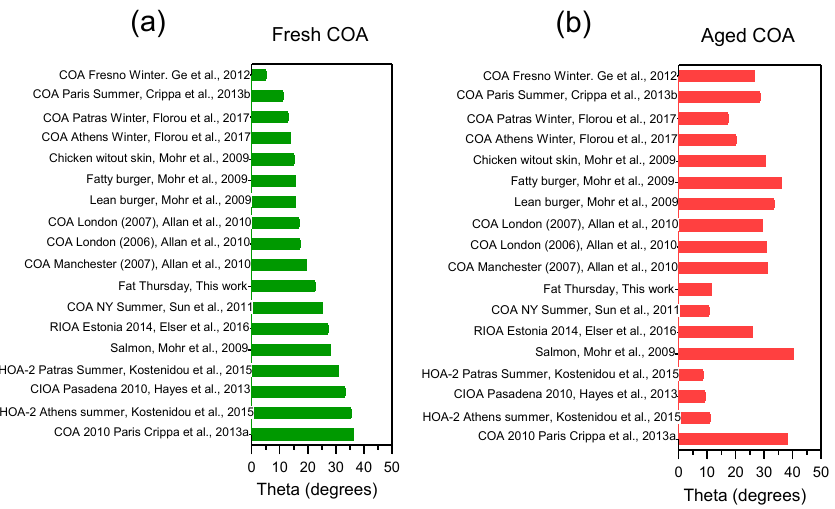
Figure 11. Angles θ between COA factors and the (a) fresh meat charbroiling emissions (average fresh spectrum) and (b) aged (average of the UV exposure experiments) meat charbroiling